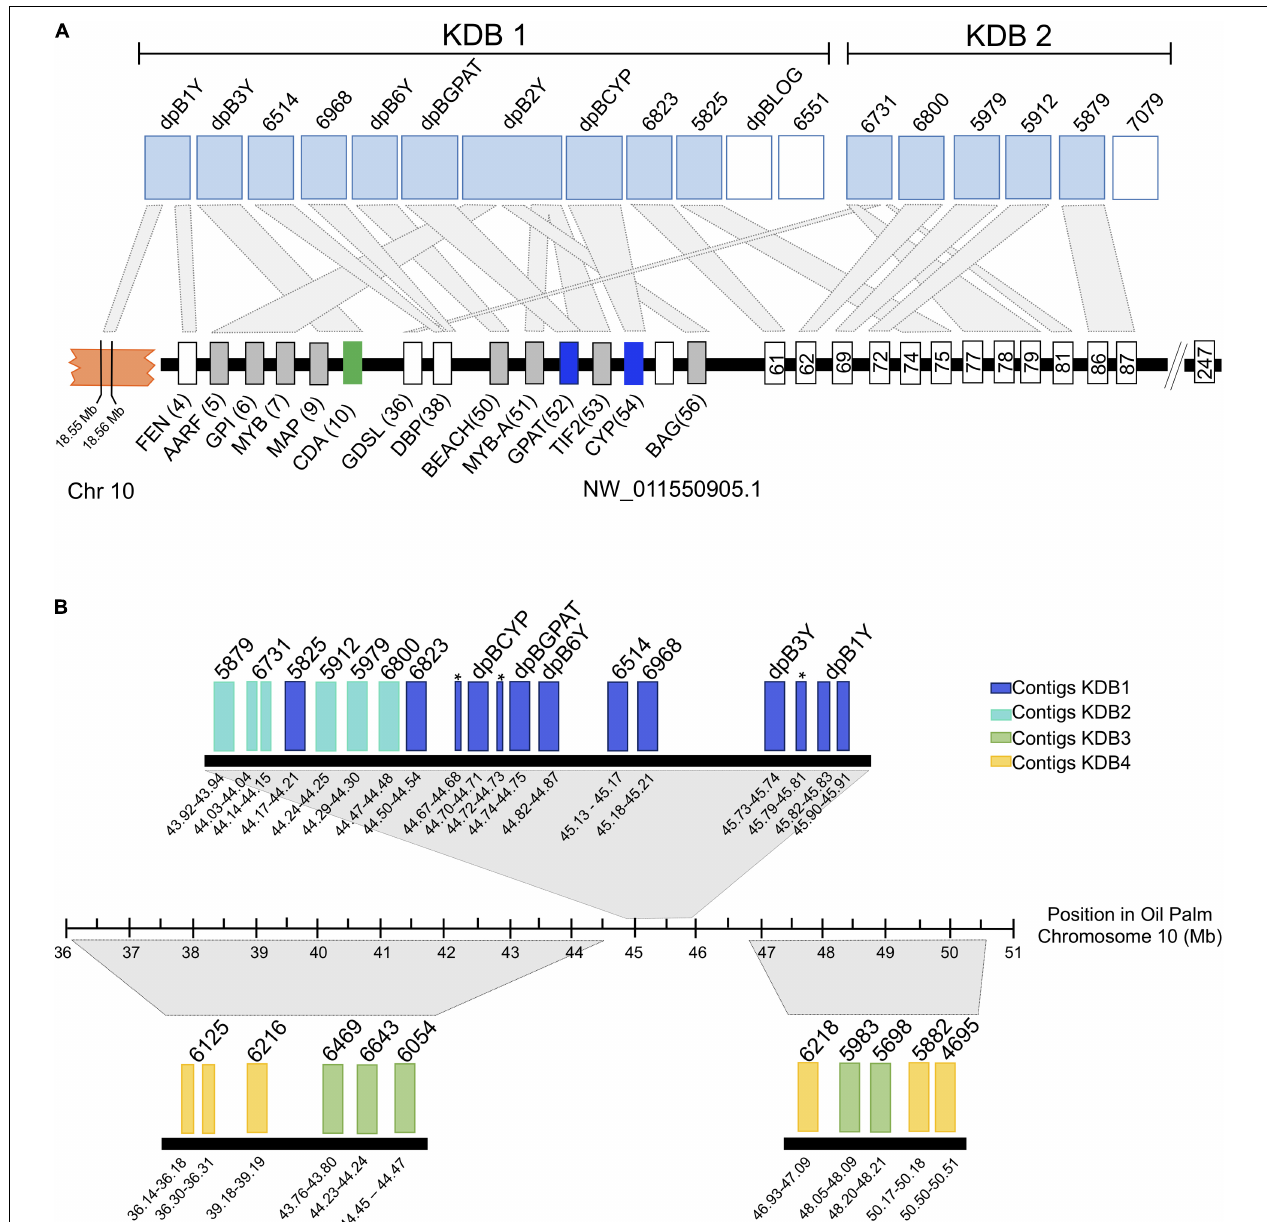
FIGURE 5 | Alignment of the date palm male-rich kmer contigs to the current oil palm reference genome from kmer density blocks 1 and 2 (A) and all with significant alignment against the new oil palm assembly (B) . For panel (A) Rectangles at the top represent date palm contigs with high similarity (light blue) or no similarity with any oil palm transcript (white). Black rectangles represent contigs with similarity to other oil palm chromosomes The smaller rectangles at the bottom represent oil palm genes and the numbers indicate their predicted position within the scaffold. Homology between date palm contigs (top) and oil palm (bottom) is represented by light-gray rectangles. The orange block represents chromosome 10 and the numbers indicate approximate locations of the transcripts with homology to date palm contigs. For panel (B) the rectangles represent date palm contigs with high similarity with oil palm chromosome 10 (GeneBank accession GK000085.1). Large regions of homology between date palm contigs and oil palm are represented by gray trapezoids. The numbers below each contig indicate their approximate location in chromosome 10. The dark blue rectangles represent contigs within kmer density block 1 (KDB1). Lighter blue, green and yellow rectangles represent contigs within KDB2, KDB3, and KDB4, respectively. Asterisks appear next to dpB2Y alignments that split across the region. KDB, Kmer Density Block. FEN: LOC105059737; AARF: LOC105059738; GPI: LOC105059739; MYB: LOC105059740; MAP: LOC105059742; CDA: LOC105059743; GDLS: